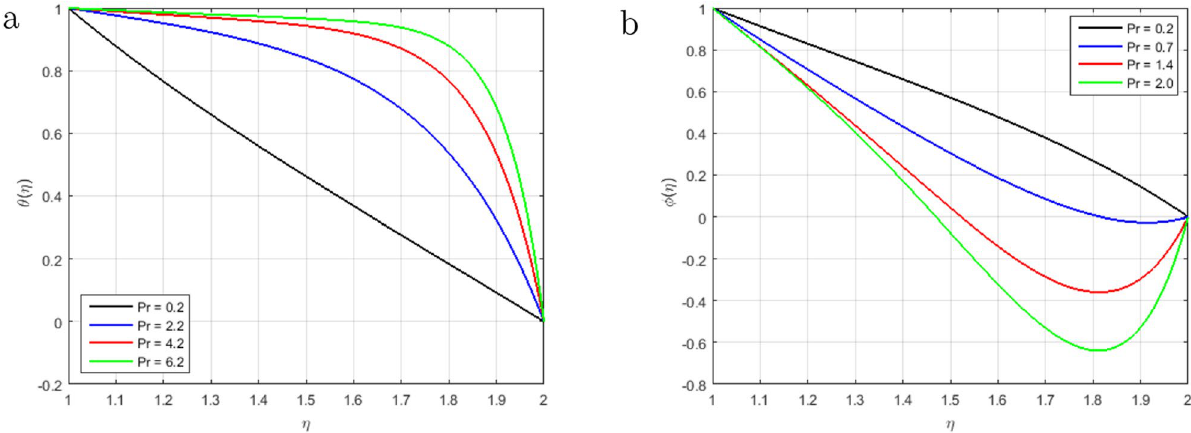
Figure 9. Influence of θ(η) and φ(η) for Pr and fixed values of S = 2.5, M = 1.4, Re m = 2.5, Hs = 1.2, C 1 = 1.4, Sc = 1.4, Sr = 2.5 .